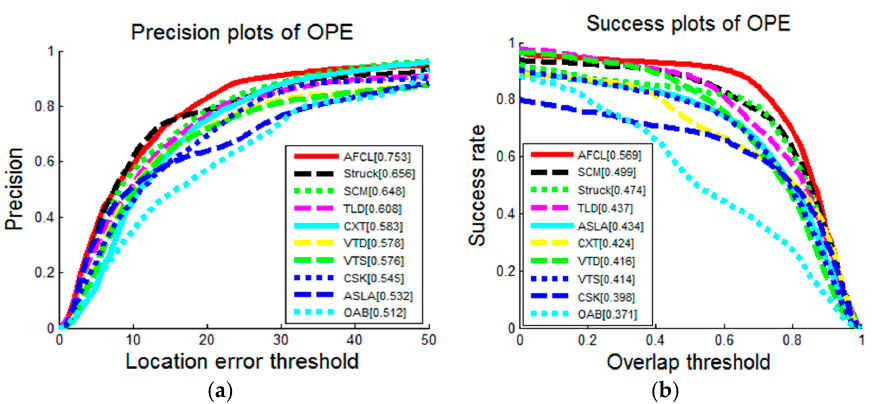
Figure 9. The precision plots and the success plots of OPE for top 10 trackers. Each tracker is ranked by the performance score. In the precision plot, the score is at error threshold of 20 pixels. In the success plot, the score is the AUC value. Table 1. Average success scores on different attributes: IV (illumination variation), OPR (out-of-plane rotation), SV (scale variation), OCC (occlusion), DEF (deformation), MB (motion blur), FM (fast motion), IPR (in-plane rotation), OV (out-of-view), BC (background cluttered) and LR (low resolution). The best results are in red and the second best results are in green.